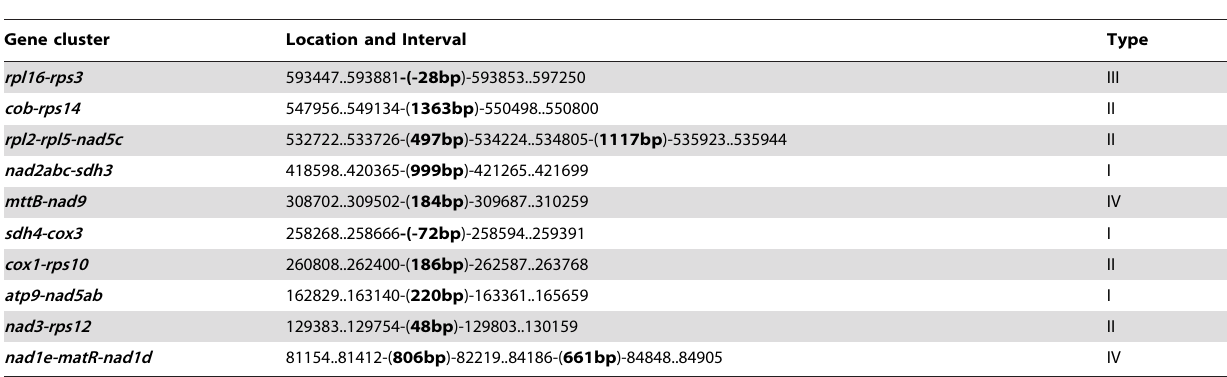
Table 1. Information of gene clusters in Gossypium hirsutum mt genome.